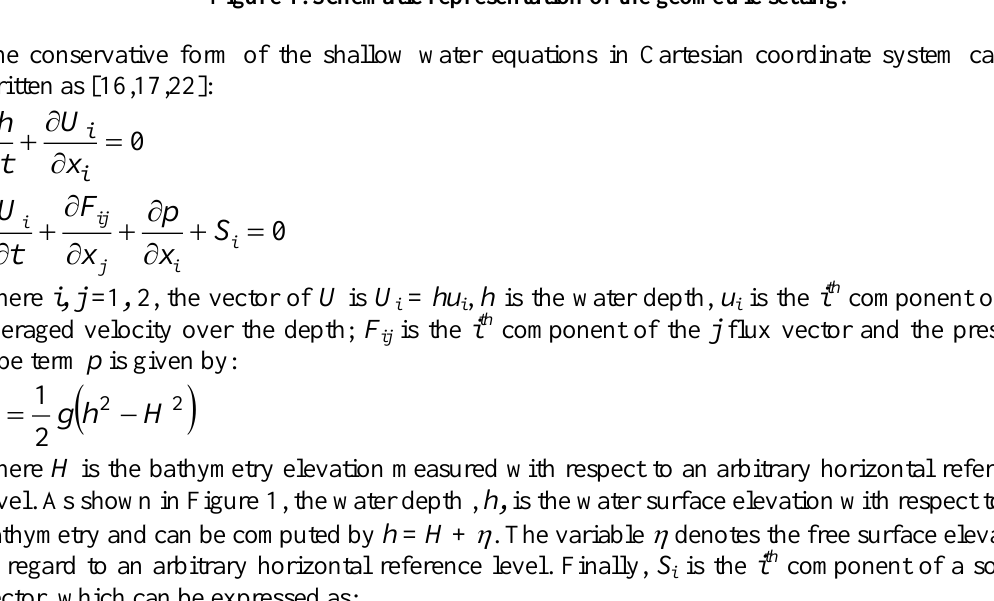
Figure 1. Schematic representation of the geometric